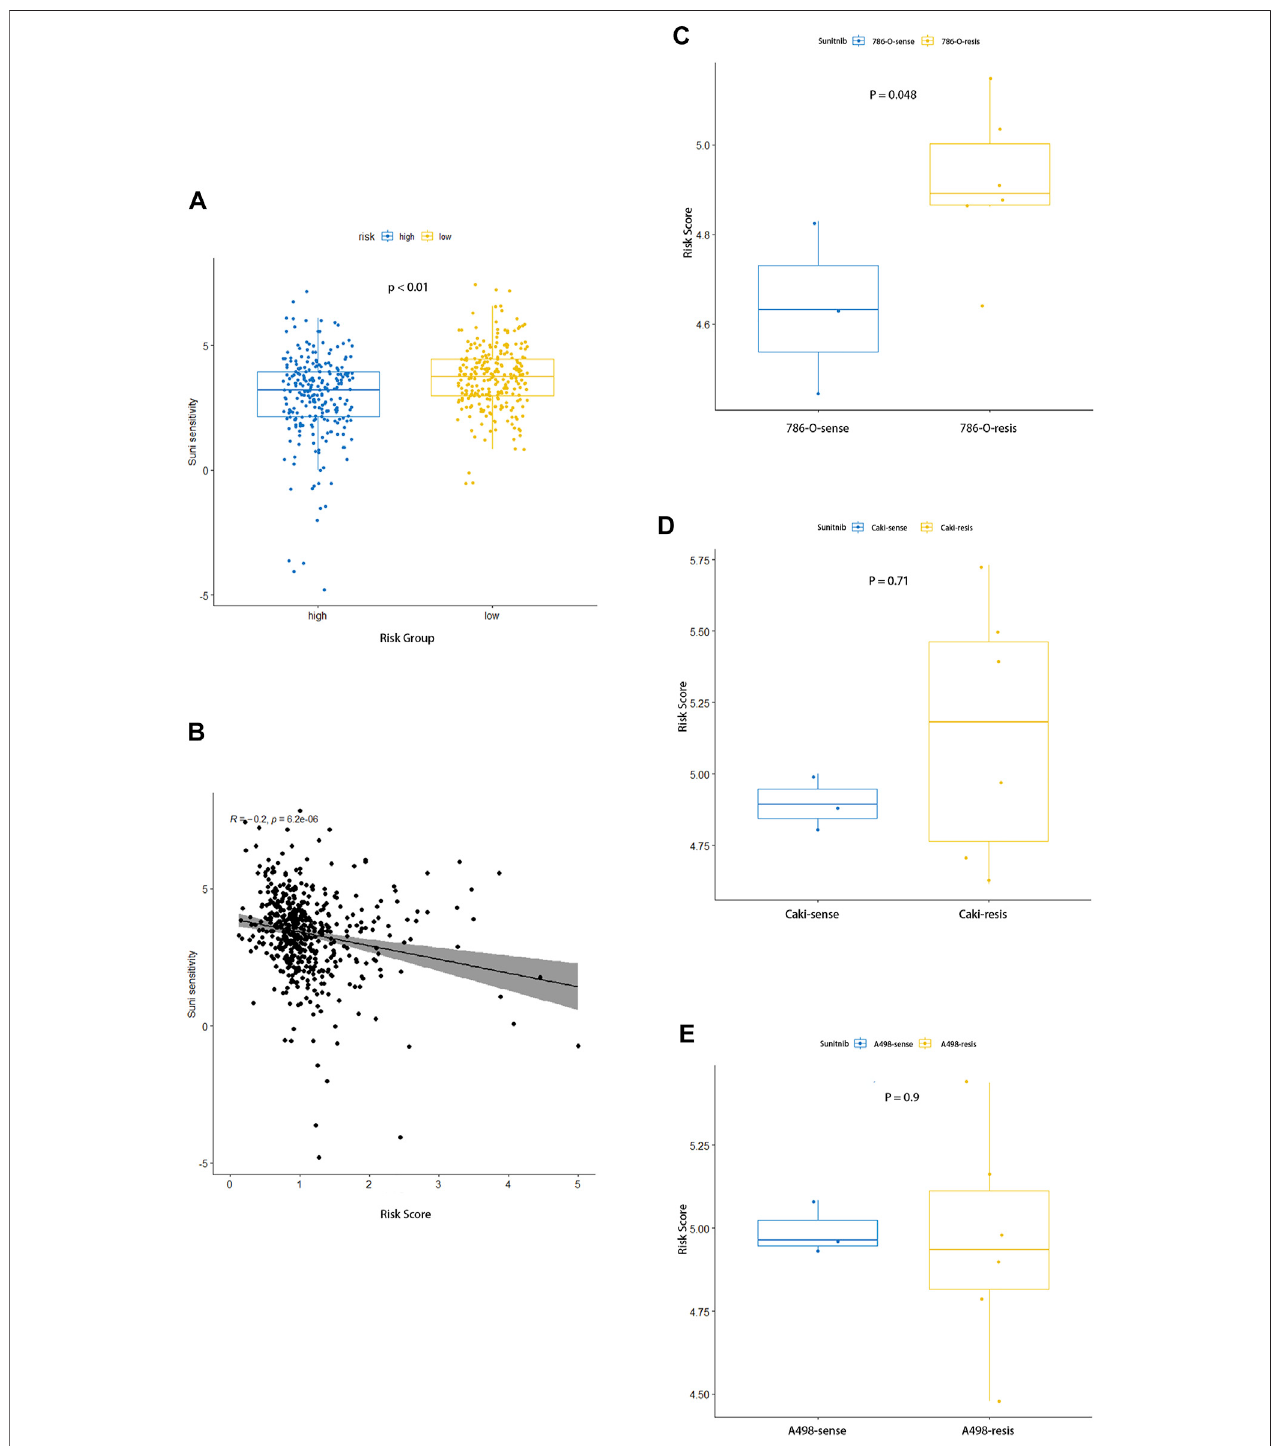
FIGURE 9 | Association between the risk signature and response to sunitinib. (A) Comparison of sensitivity to sunitinib between the two groups. (B) Correlation analysisfor the riskscore and the sensitivity tosunitinib. (C – E) Distinction in riskscore between parental and corresponding resistant renalcarcinoma celllinesof786-O (C) , Caki (D), and A498 (E) .